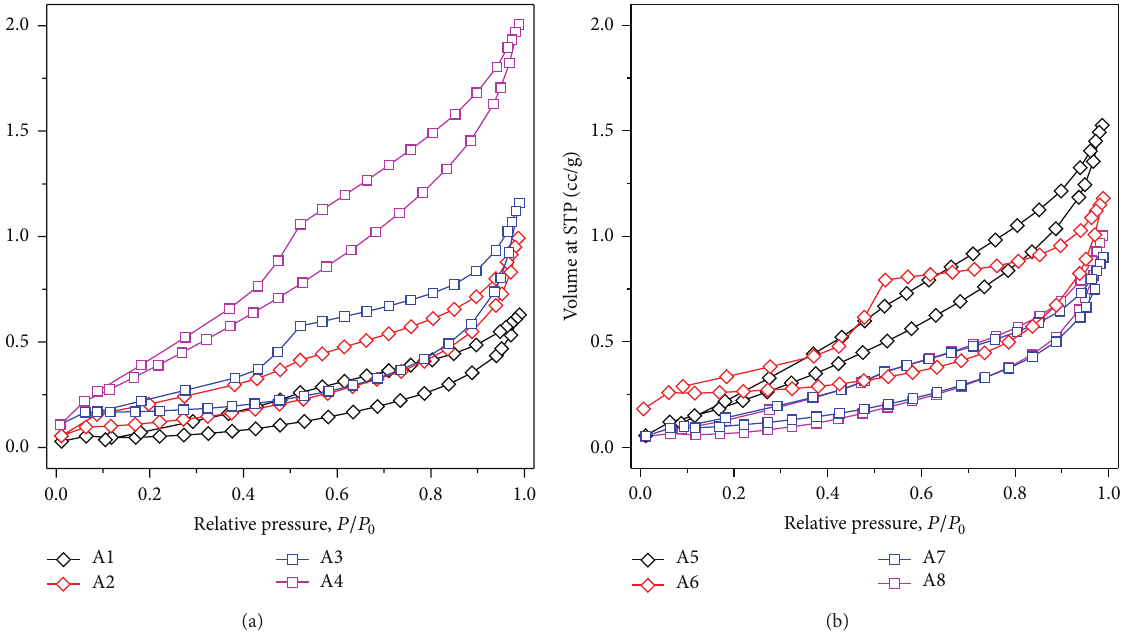
Figure 1: N 2 adsorption/desorption isotherms (77K) of the samples.